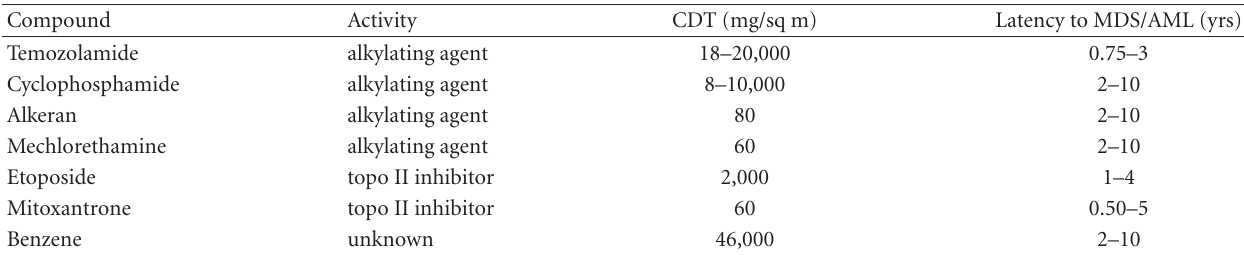
Table 1: Estimated CDT for selected potentially leukemogenic